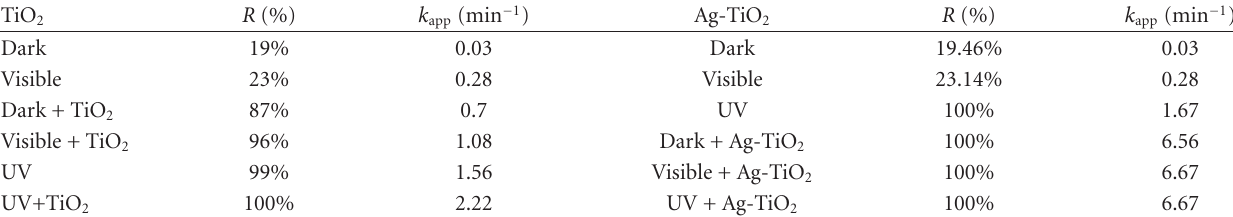
Table 2: Values of R (%) and k app by using di ff erent light sources and di ff erent photocatalysts of TiO 2 and Ag-TiO 2 or light